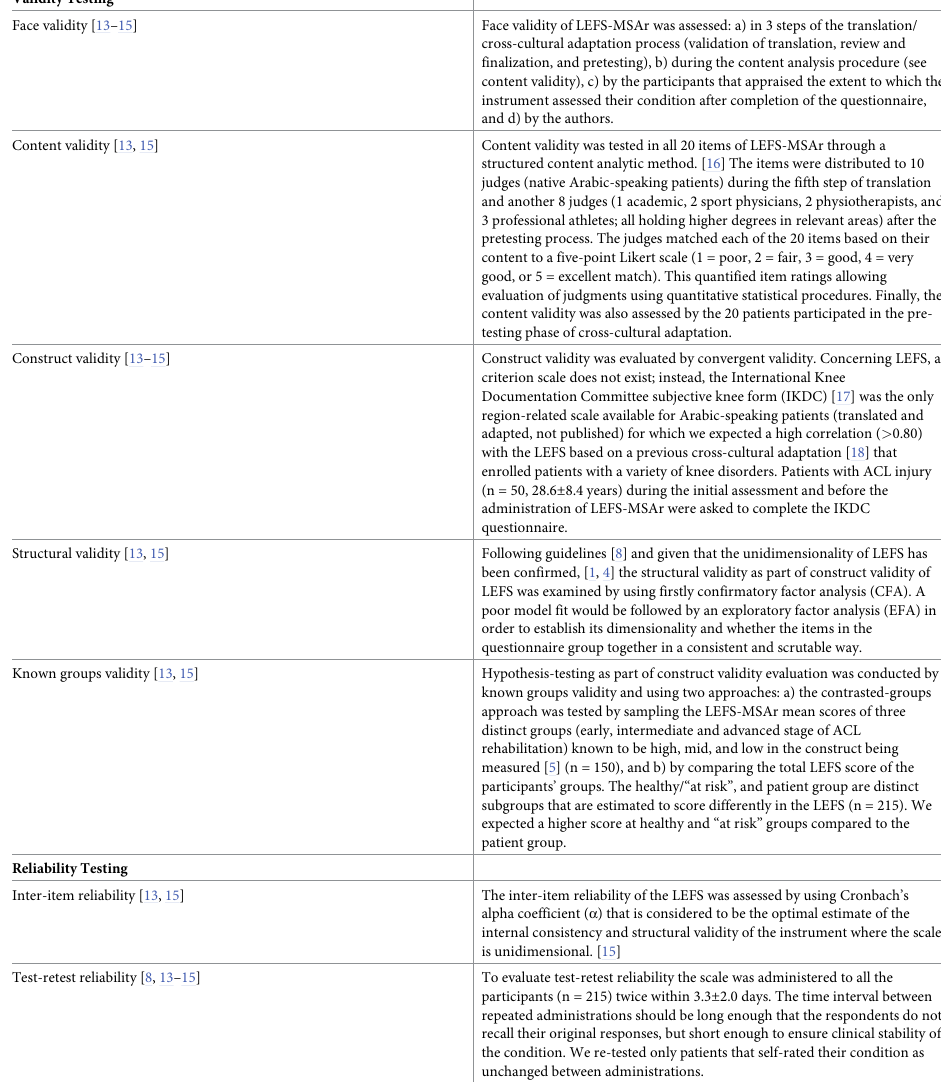
Table 2. Measurement and psychometric properties assessed for the LEFS-MSAr